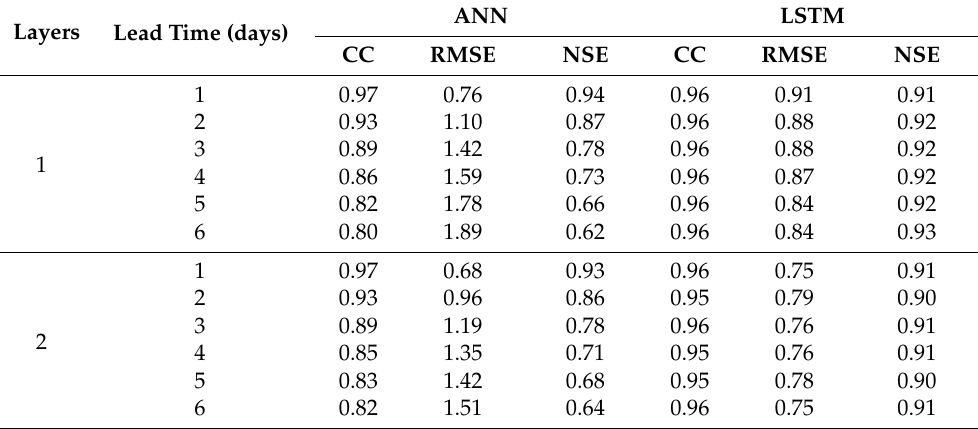
Figure 4. Comparison of predicted soil moisture with observations for the four layers (( a ): Layer 1, ( b ): Layer 2, ( c ): Layer 3, ( d ): Layer 4) using two data-driven models. Table 1. Evaluation results obtained by statistical metrics for estimated soil moistures from the two